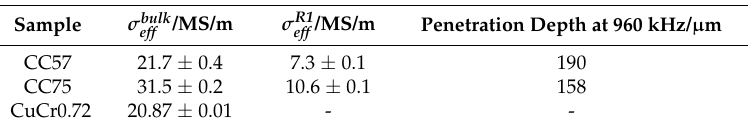
Table 4. Determined electrical conductivity of bulk material and (mostly) R1 as well as the penetration depth at 960 kHz (with σ eff R1 /) for CC57 and CC75.